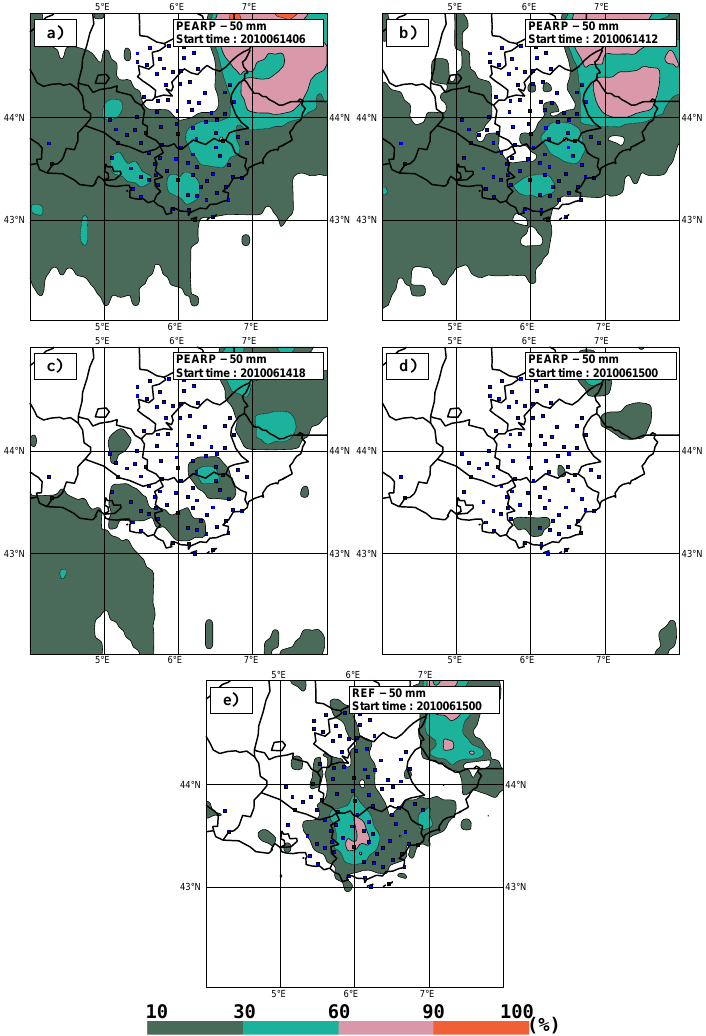
Fig. 5. Var case probability map for the 24-h accumulated precipitation (valid at 06:00UTC on 16 June 2010) exceeding 50mm and for the PEARP ensemble starting at: (a) 06:00UTC, 14 June 2010, (b) 12:00UTC, 14 June 2010, (c) 18:00UTC, 14 June 2010 and (d) 00:00UTC, 15 June 2010. (e) and (f) stand for the REF convective-permitting ensemble experiment starting at 00:00UTC, 15 June 2010 and for the thresholds 50 and 100mm. The squares are observations (rain-gauges) over the same